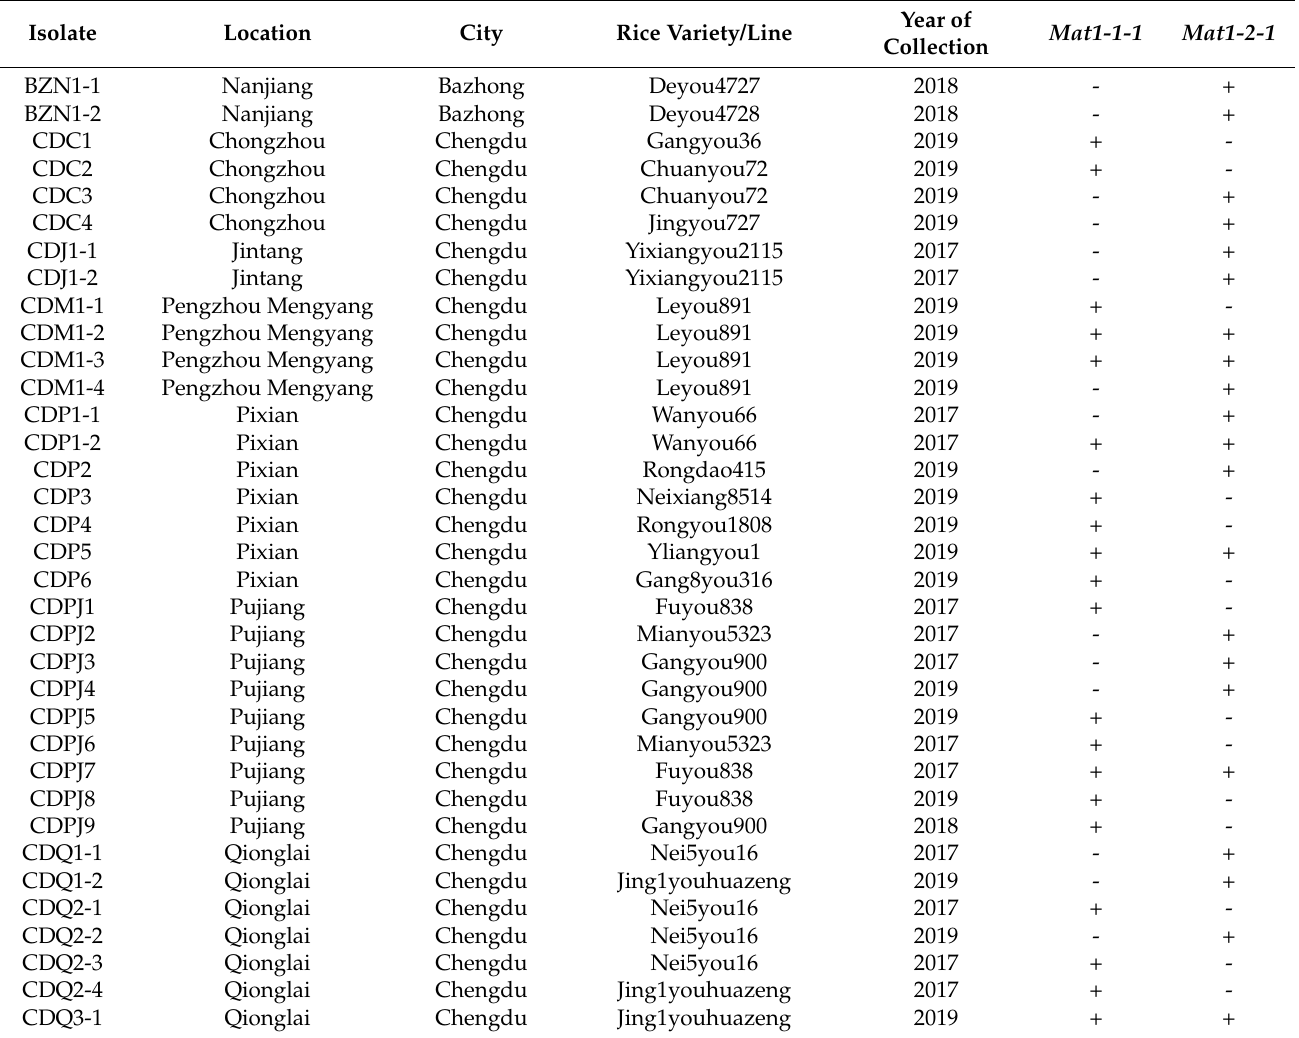
Table 1. Different strains of Ustilaginoidea virens collected from southwest China in the